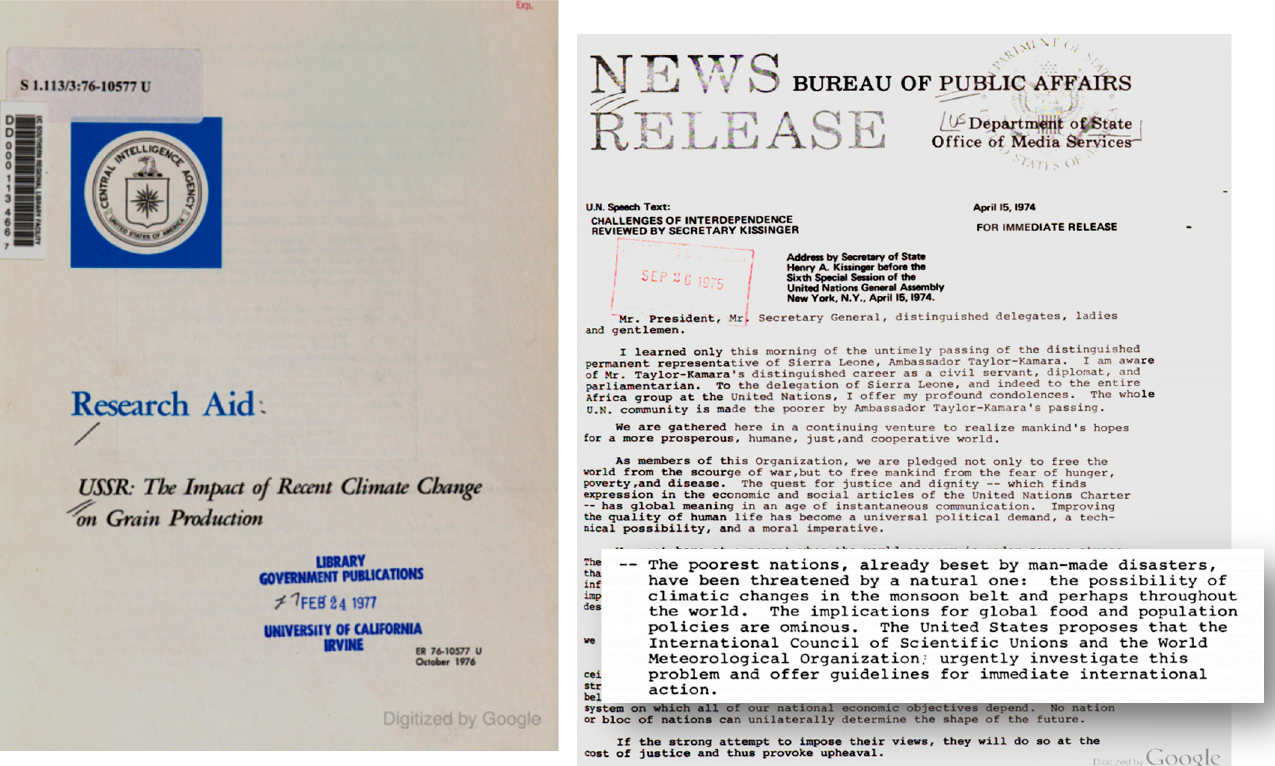
Figure 10. ( left ) The earliest item in the Google Books collection, which includes the term “Climate Change” in its title [89]. ( right ) Kissinger’s (1974) Address to the Sixth Special Session of the United Nations General Assembly [90] with the inset showing the most interesting quotation about “climatic changes”.